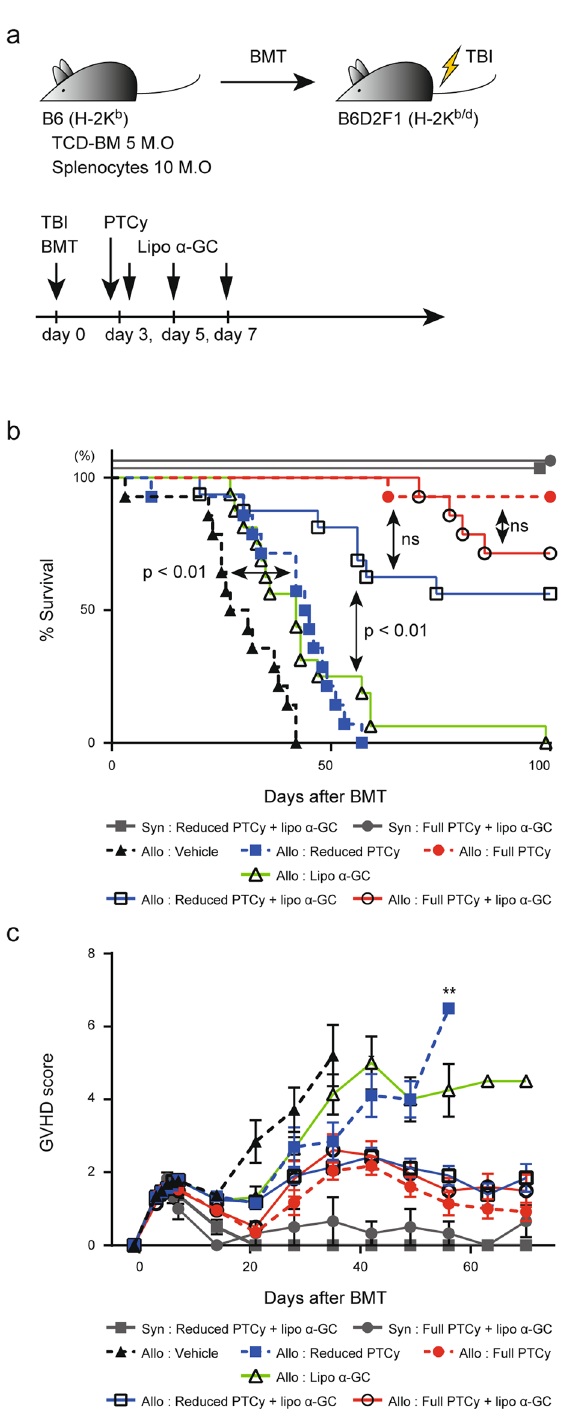
Figure 2. Lipo α-GC improves both the percent survival and the GVHD score impaired by reducing the dose of PTCy. ( a ) Experimental scheme: 5 × 10 6 TCD-BM cells and 10 × 10 6 splenocytes from B6 donor mice were administered to lethally irradiated (12 Gy TBI) B6D2F1 recipient mice. Cyclophosphamide or a control vehicle was administered on day 3, followed by lipo α-GC administration on days 3, 5 and 7 after BMT. ( b ) Overall survival rates of the vehicle (n = 14), reduced PTCy (n = 14), full PTCy (n = 14), lipo α-GC (n = 16), reduced PTCy plus lipo α-GC (n = 16) and full PTCy plus lipo α-GC (n = 14) groups at serial time points. Data are representative of four independent experiments. P values were determined by the log-rank test and Holm’s adjustment for multiple comparisons. ns, not significant ( P > 0.05). ( c ) Clinical scores of the vehicle (n = 14), reduced PTCy (n = 14), full PTCy (n = 14), lipo α-GC (n = 16), reduced PTCy plus lipo α-GC (n = 16) and full PTCy plus lipo α-GC (n = 14) groups at serial time points. Data are representative of four independent experiments and expressed as the mean ± SEM. P values were determined by one-way ANOVA and Tukey’s adjustment for multiple comparisons (allogeneic: reduced PTCy vs allogeneic: reduced PTCy plus lipo α-GC). * P <